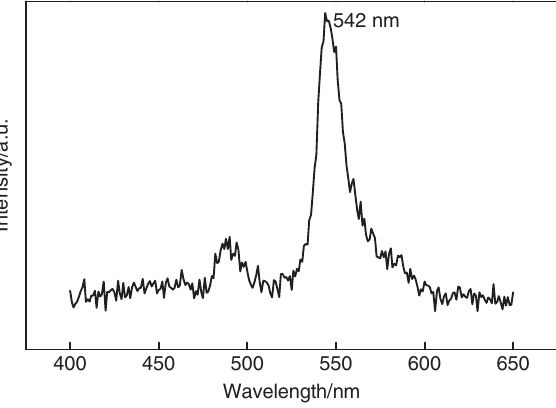
Figure 2: Fluorescence spectrum of 70ZnO – 10P 2 O 5 – 20SiO 2 – 5Tb 3 þ